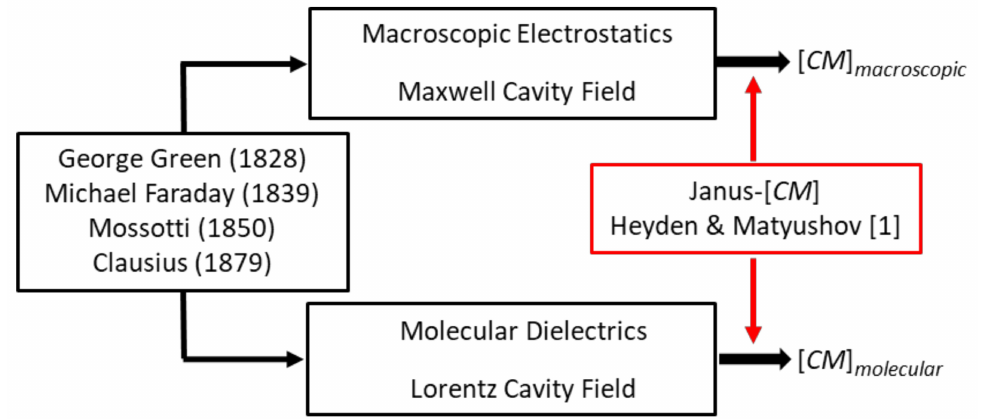
Figure 1. Standard DEP theory employs macroscopic electrostatics to calculate an induced dipole mo- ment and the Clausius–Mossotti factor, [ CM ] macroscopic . The DEP of particles possessing a permanent dipole moment is better formulated within the context of the Clausius–Mossotti law of molecular dielectrics ([ CM ] molecular ). The new theory [1] holds the key to transitioning between the two [ CM ]s, whose origins trace back to Green [7], Faraday [8], Mossotti [9] and Clausius